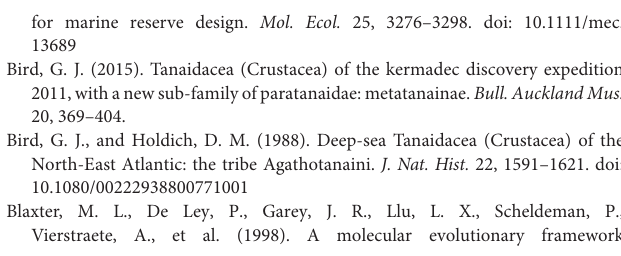
Supplementary Table 2 | Pairwise genetic distances between agathotanaids species for H3 and 18S sequences. Supplementary Material | Key for Agathotanais